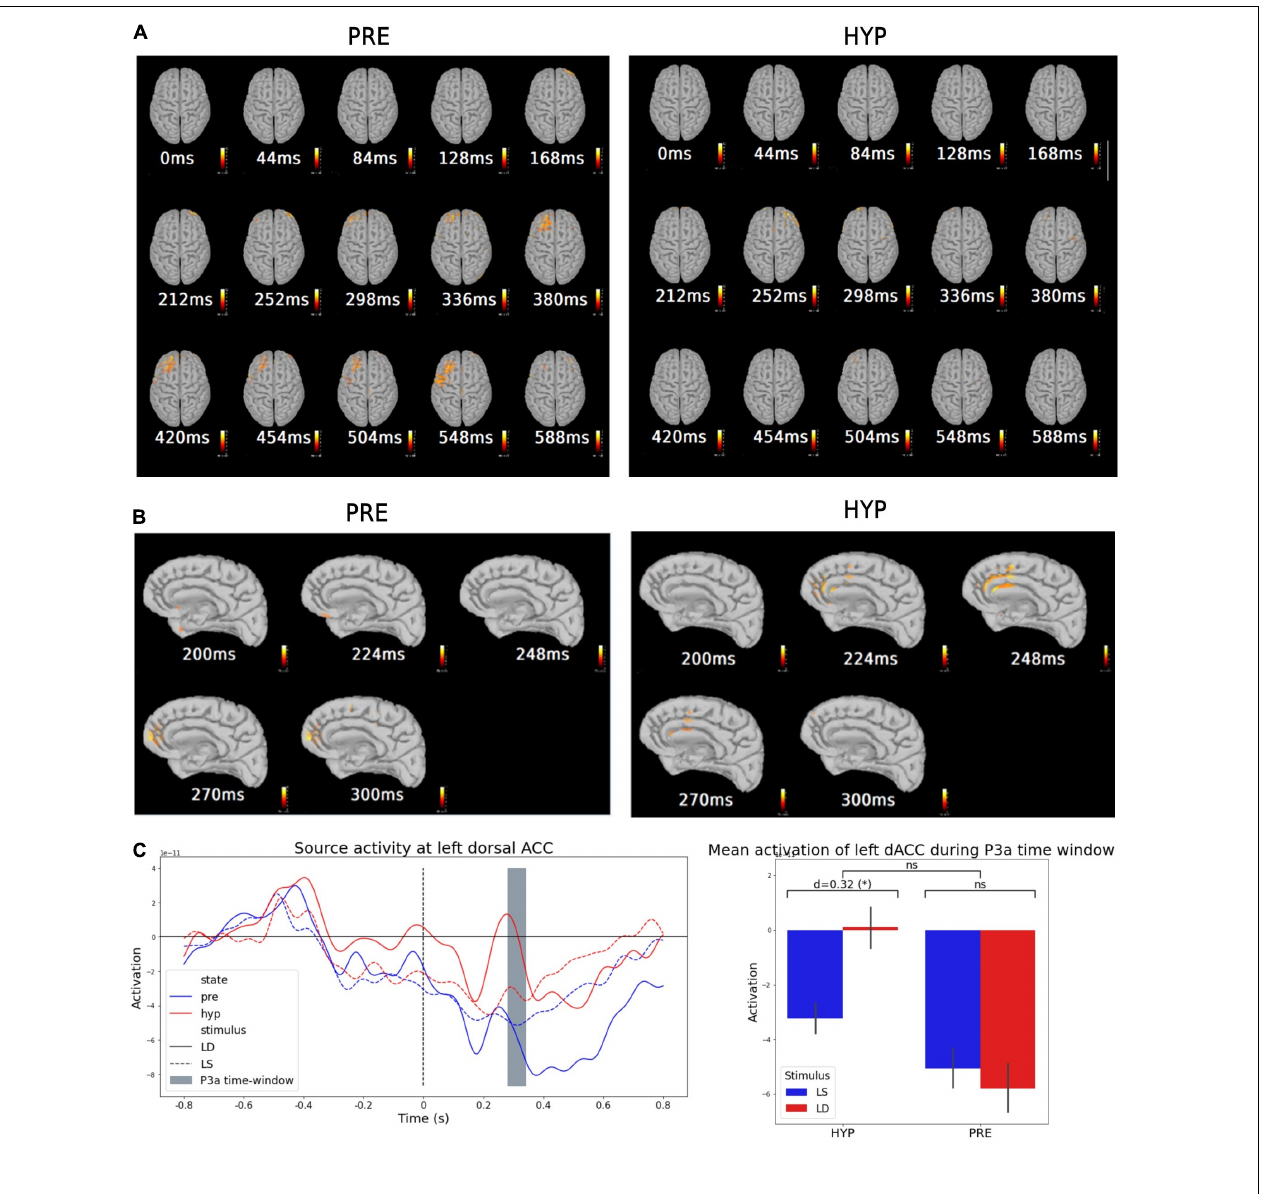
FIGURE 3 | Source modeling suggested an inhibitory activation of medial prefrontal structures (dACC) during hypnotic deafness preventing activation of dorso-lateral prefrontal areas. Source modeling of the evoked-related potentials during baseline (PRE) and hypnotic deafness (HYP) conditions. (A,B) Sources of the mean evoked odd-ball effect (average of deviant trials minus average of standard trials) for PRE (left) and HYP (right) conditions [ t -test against the 800 ms baseline before the onset of the 5th sound, FDR corrected in time and space dimensions (alpha = 0.001)]. While a dorso-lateral prefrontal activation was observed from 298 to 548 ms in the PRE condition (previously associated with conscious access), this activation was not observed in the HYP condition. (B) Presents a right-medial sagittal view during the 200–300 ms time-window, where a transient activation of medial prefrontal structures (and in particular dorsal anterior cingulate cortex) was observed exclusively in the HYP condition. (C) Source activity at left dorsal anterior cingulate cortex (dACC). Left panel: Time-series of the average source activity in the left dACC, in function of stimulus [standard (LS): dotted lines; deviant (LD): complete lines] and state (PRE: blue; HYP: red). The predefined P3a time-window is colored in gray. Right panel: Mean activation of left dACC during the P3a time-window, for standard (LS, blue) and deviant (LD, red) stimuli, in function of state (PRE and HYP). The plot shows the interaction effect of state × stimulus and the pairwise comparison of standard and deviant stimuli for each state. Greater activation of left dACC was observed for deviant trials exclusively in the HYP condition. ns: non-significant ( p -value > 0.05); * p -value <